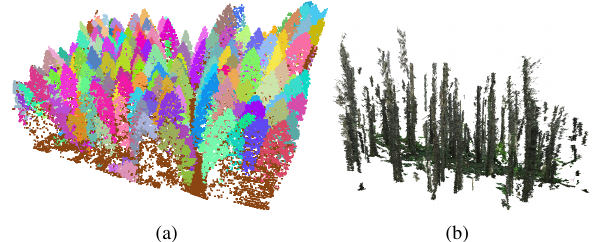
Figure 5: Target area - (a) ALS point cloud (color by single trees),